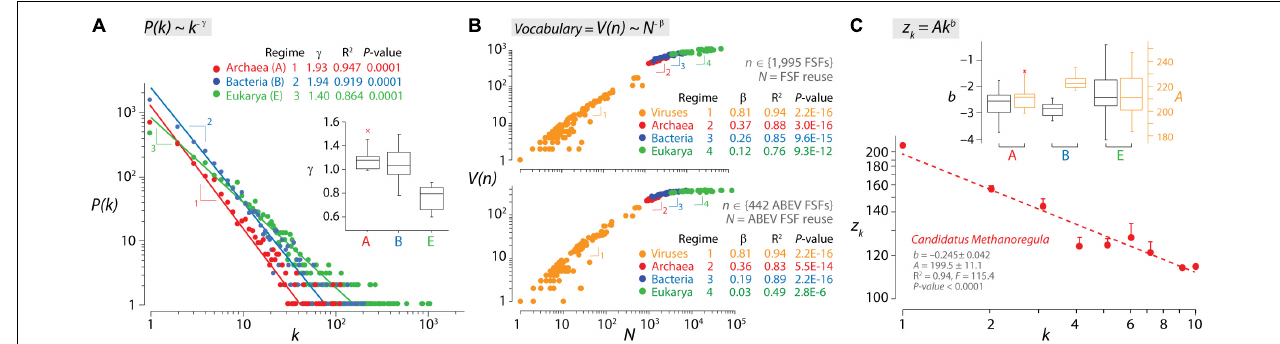
FIGURE 2 | Laws of language describe growth of structural domains in proteomes. (A) The double logarithmic plot describes the relationship between the frequency of individual protein folds, P(k ), occurring k times in the proteomes of Archaea (A), Bacteria (B), and Eukarya (E), which follows a Zipf’s law. The relationship between frequency and occurrence was fitted to a straight line that drops off sharply with different regimes (indicated by numbers) for the proteomes of Archaea/Bacteria and for those of Eukarya. Additional power law statistics for individual regimes [ α = 2.000 (cid:29) 1; Kolmogorov–Smirnov (KS) fit = 0.169–0.328 (cid:28) 1, KS p -value = 0.132–0.174 ≥ 0.05] supported the data being drawn from a power law distribution. Regimes are also evident for individual proteomes in boxplots of parameters of exponential decay γ . Data from Caetano-Anollés and Caetano-Anollés (2003). (B) The double logarithmic plots describe a four-regime Heaps’ law of vocabulary growth for structural domains defined at fold superfamily (FSF) level for all 1,995 FSFs (top plot) or only for the 442 FSFs that are common to all superkingdoms and viruses (ABEV FSFs; bottom plot). Archaea, Bacteria, Eukarya, and viruses have their own power law regime of allometric scaling. V(n) represents vocabulary size (use of FSFs) and N represents database size (reuse of FSFs in each of the 368 proteomes analyzed). Data from Nasir et al. (2017). (C) The Menzerath–Altmann (MA) law of language in the structural domains of an archaeal proteome. A log–log plot shows how the average length of structural domains in a protein ( z k ) decreases with the number ( k ) of structural domains it contains for the entire proteome of Candidatus Methanoregula . Vertical bars represent the standard error of the means. The two-parameter power law formulation of the MA law facilitates fitting parameters in log–log plots to a straight line. The hatched regression line indicates the weighted linear fitting. Boxplots describe decay parameters b and intercepts A (when k = 1) for the proteomes of the three superkingdoms. Data from Shahzad et al.